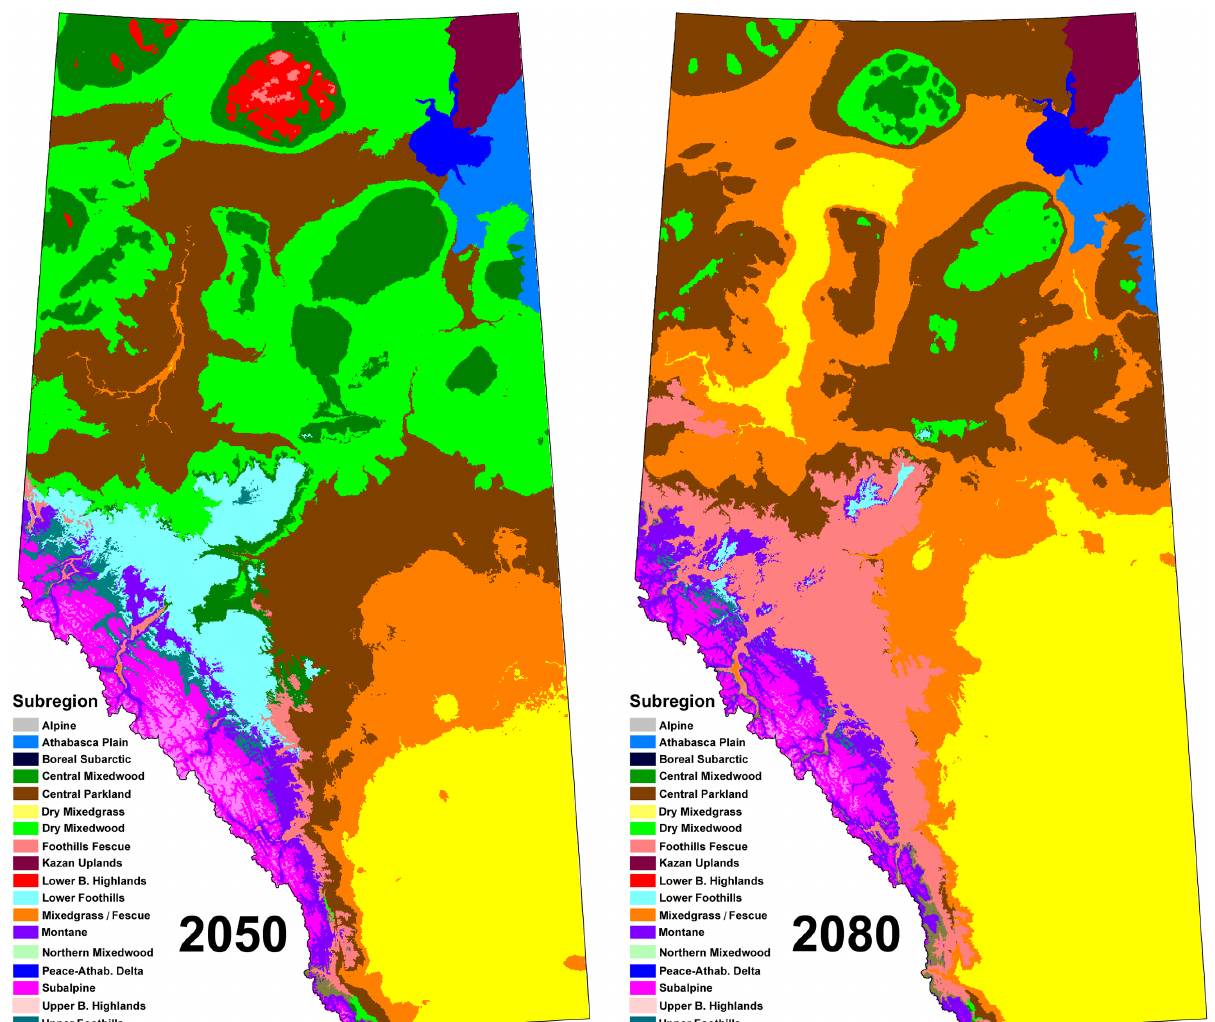
Fig 3. Climate envelope projections for the ECHAM5 – A2 GCM (median model). Panel A = 2050s; panel B = the 2080s. Three Subregions in northeast Alberta were not